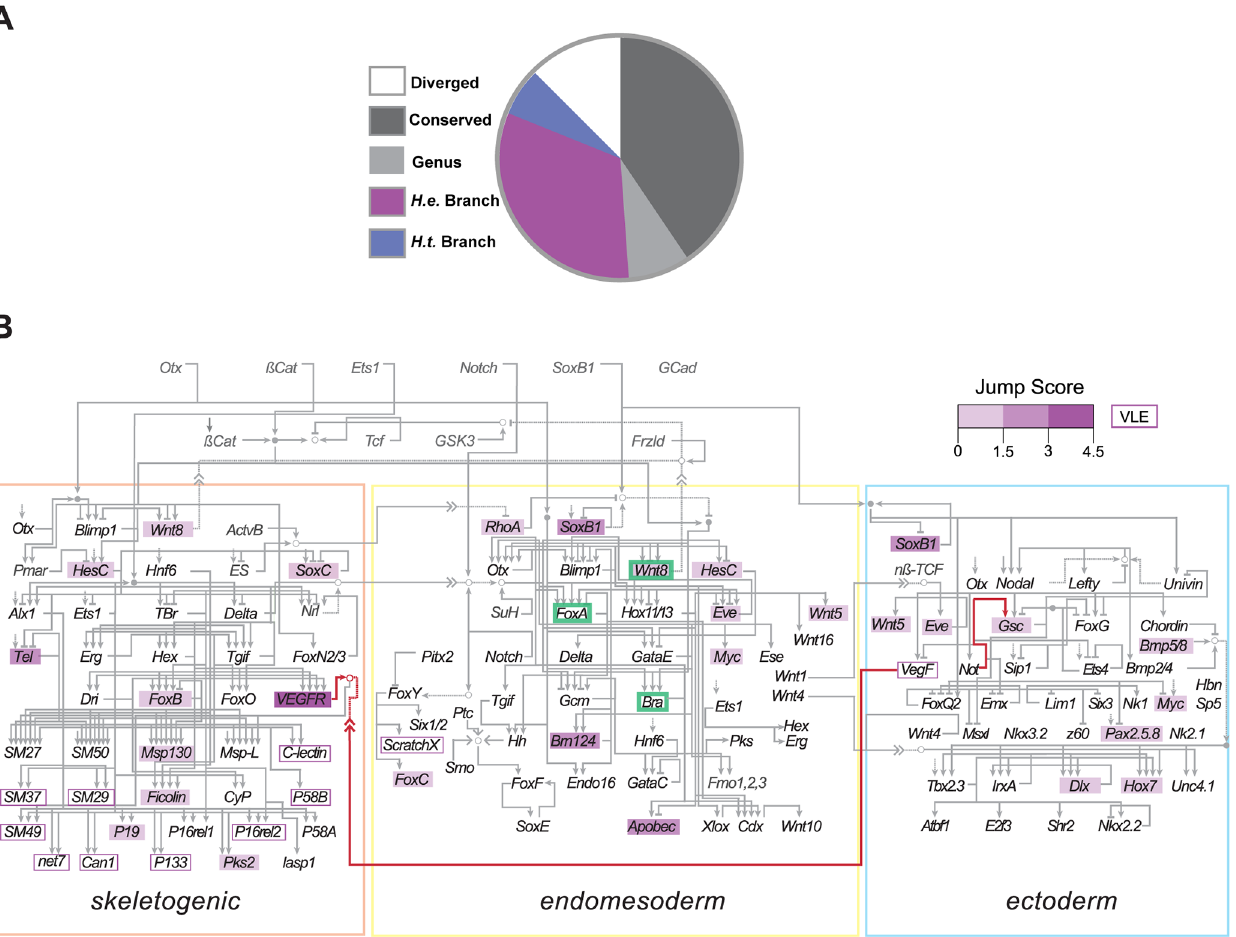
Fig 4. Life history strategy is a major component of gene expression divergence across the GRN. (A) Compared to the transcriptome, the GRN exhibits increased expression profile conservation among species (dark grey, 41.5%) and reduced divergence (white, 11.3%). Genus level and H . tuberculata -specific cluster jumps are also reduced (light grey, 8.5% and blue, 5.7%, respectively), while cluster jumps specifically along the H . erythrogramma branch increased at the GRN level compared to the transcriptome (purple, 33%) (S4 Table). (B) H . erythrogramma -specific branch jumps (purple) occur in each GRN territory, though they are concentrated in the skeletogenic lineage (Binomial test, p < 0.01). Names of genes measured in this study are shown in black, other genes in grey. The associated jump score for each H . erythrogramma -specific branch jump is represented by box color. Jumps into the VLE group are represented by open boxes. Examples of GRN change in H . erythrogramma are highlighted, including EM subcircuit compression (green boxes, S4A Fig) and altered regulatory interactions between VegF and VEGFR and between Not and Gsc (red lines, S4D – S4F Fig). Generalized categories of GRN change are depicted in S5